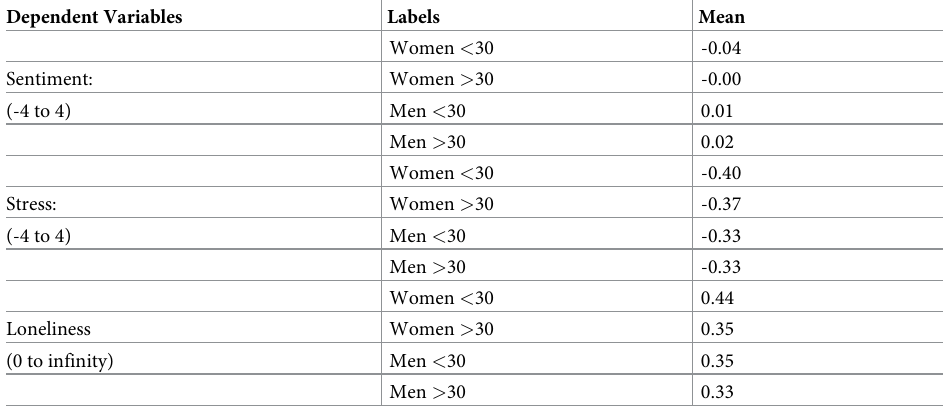
Table 3. Descriptive